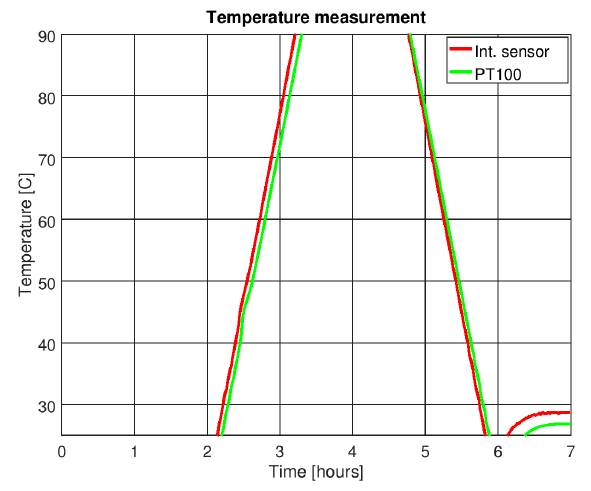
Figure 3. Temperature measurement comparison between SL900A internal sensor and PT100